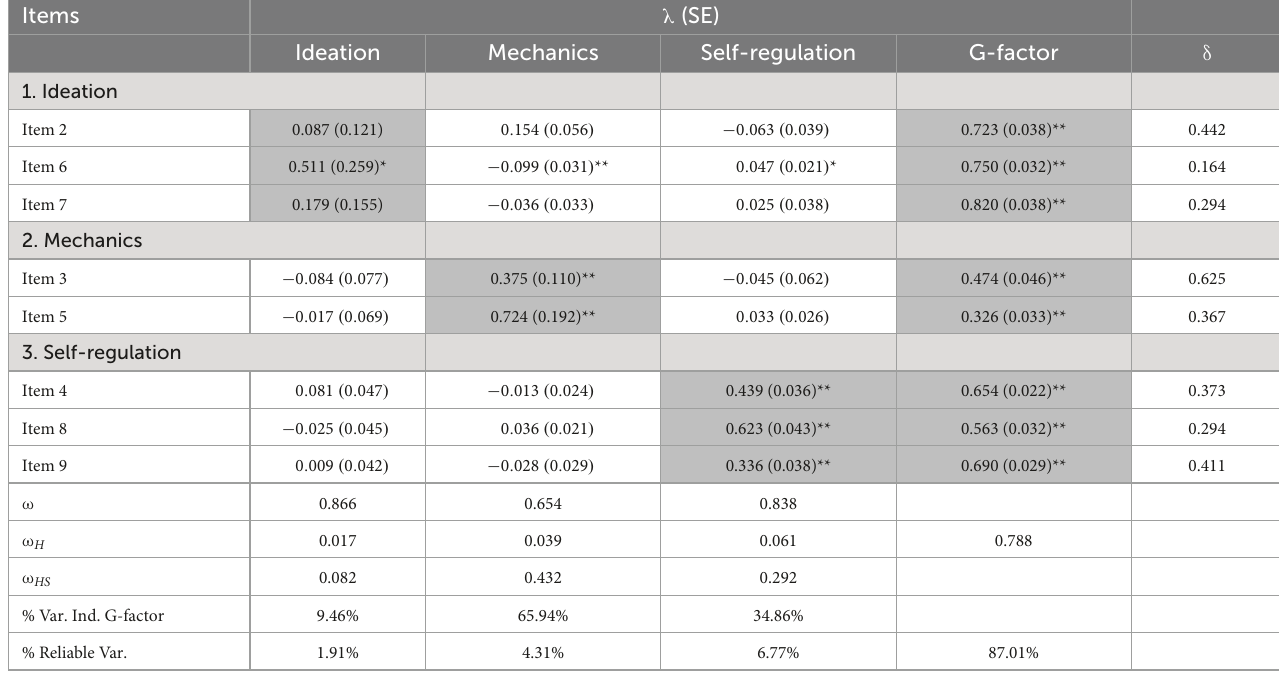
TABLE 5 Standardized factor loadings for bifactor exploratory structural equation modeling solution of the Self-Efficacy for Writing Scale ( − se1). Items